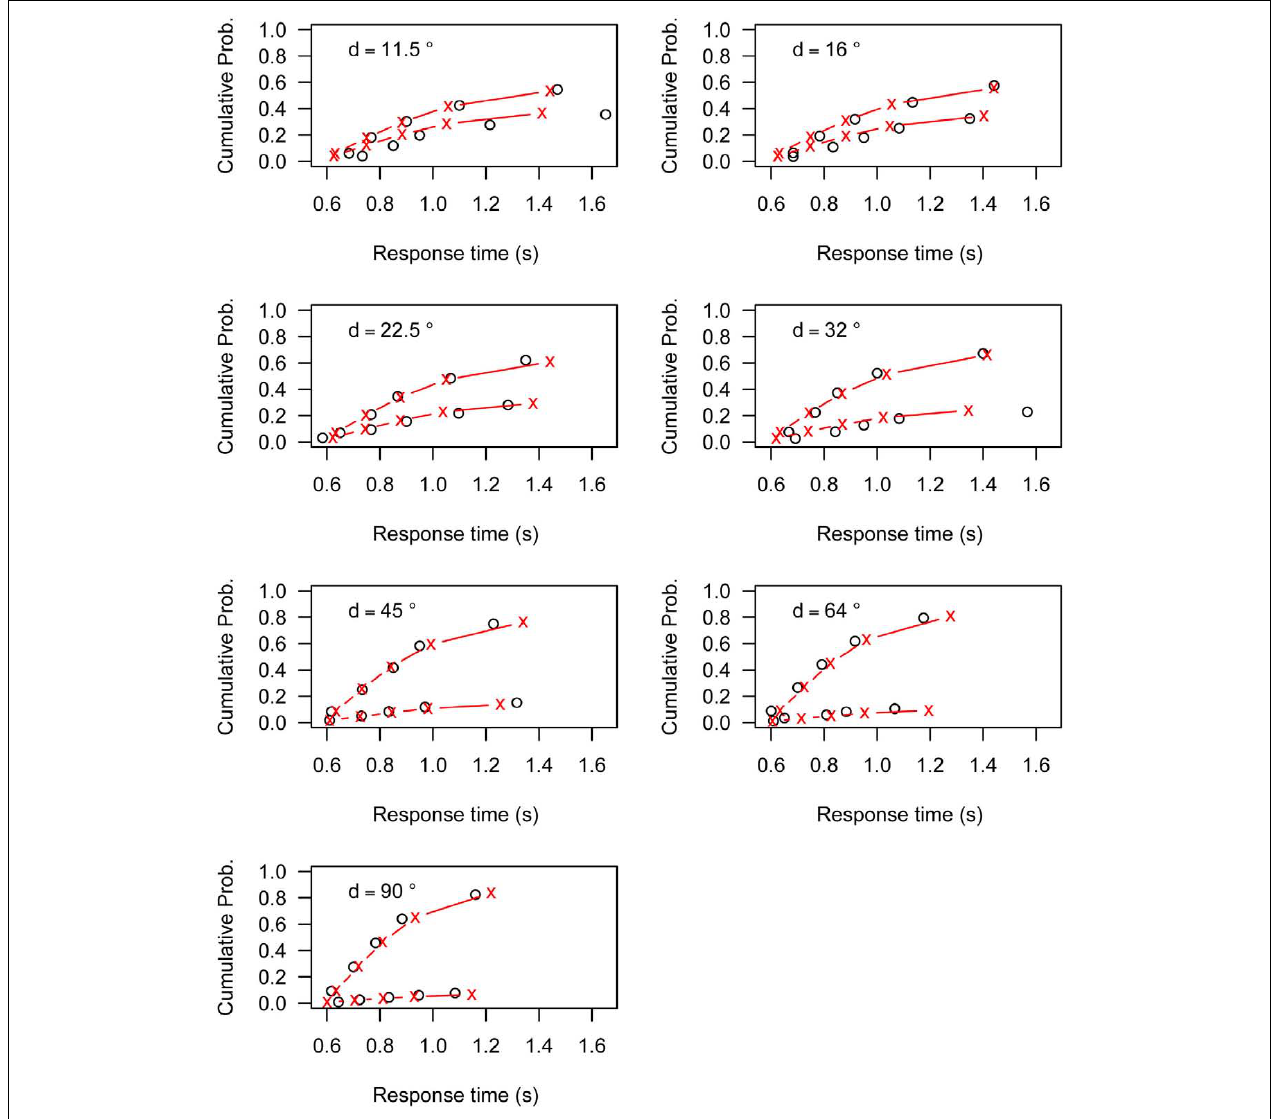
FIGUREA4 | LBA model fit for Participant